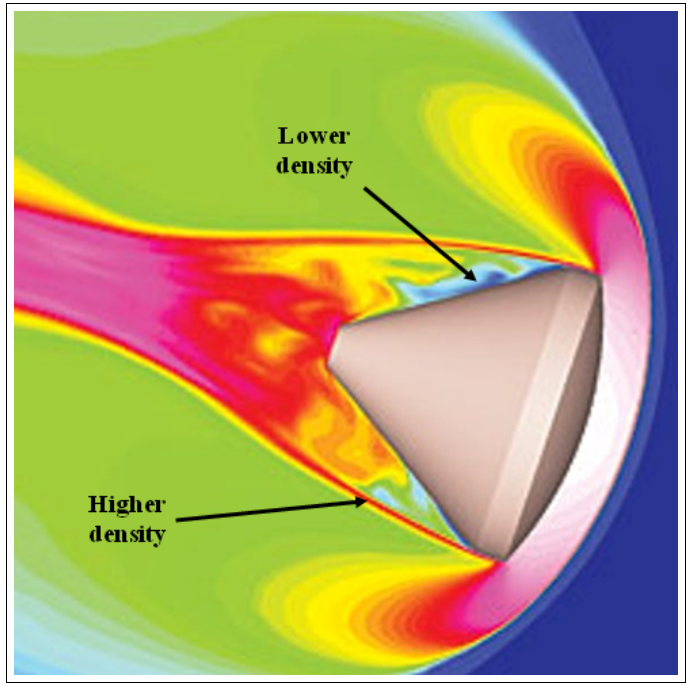
Figure 1. Illustration of the plasma sheath surrounding a reentry vehicle (modified version of the figure in [2], original figure credit: Krishnendu Sinha, IIT